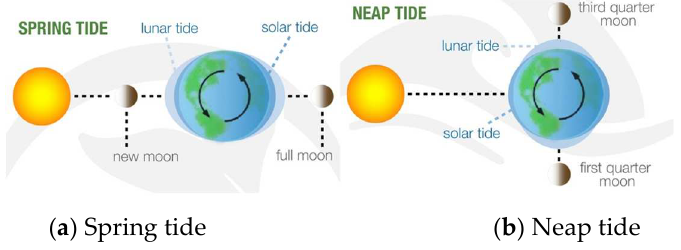
Figure 1. Relative position of the Earth, Moon and Sun at high and low tides.